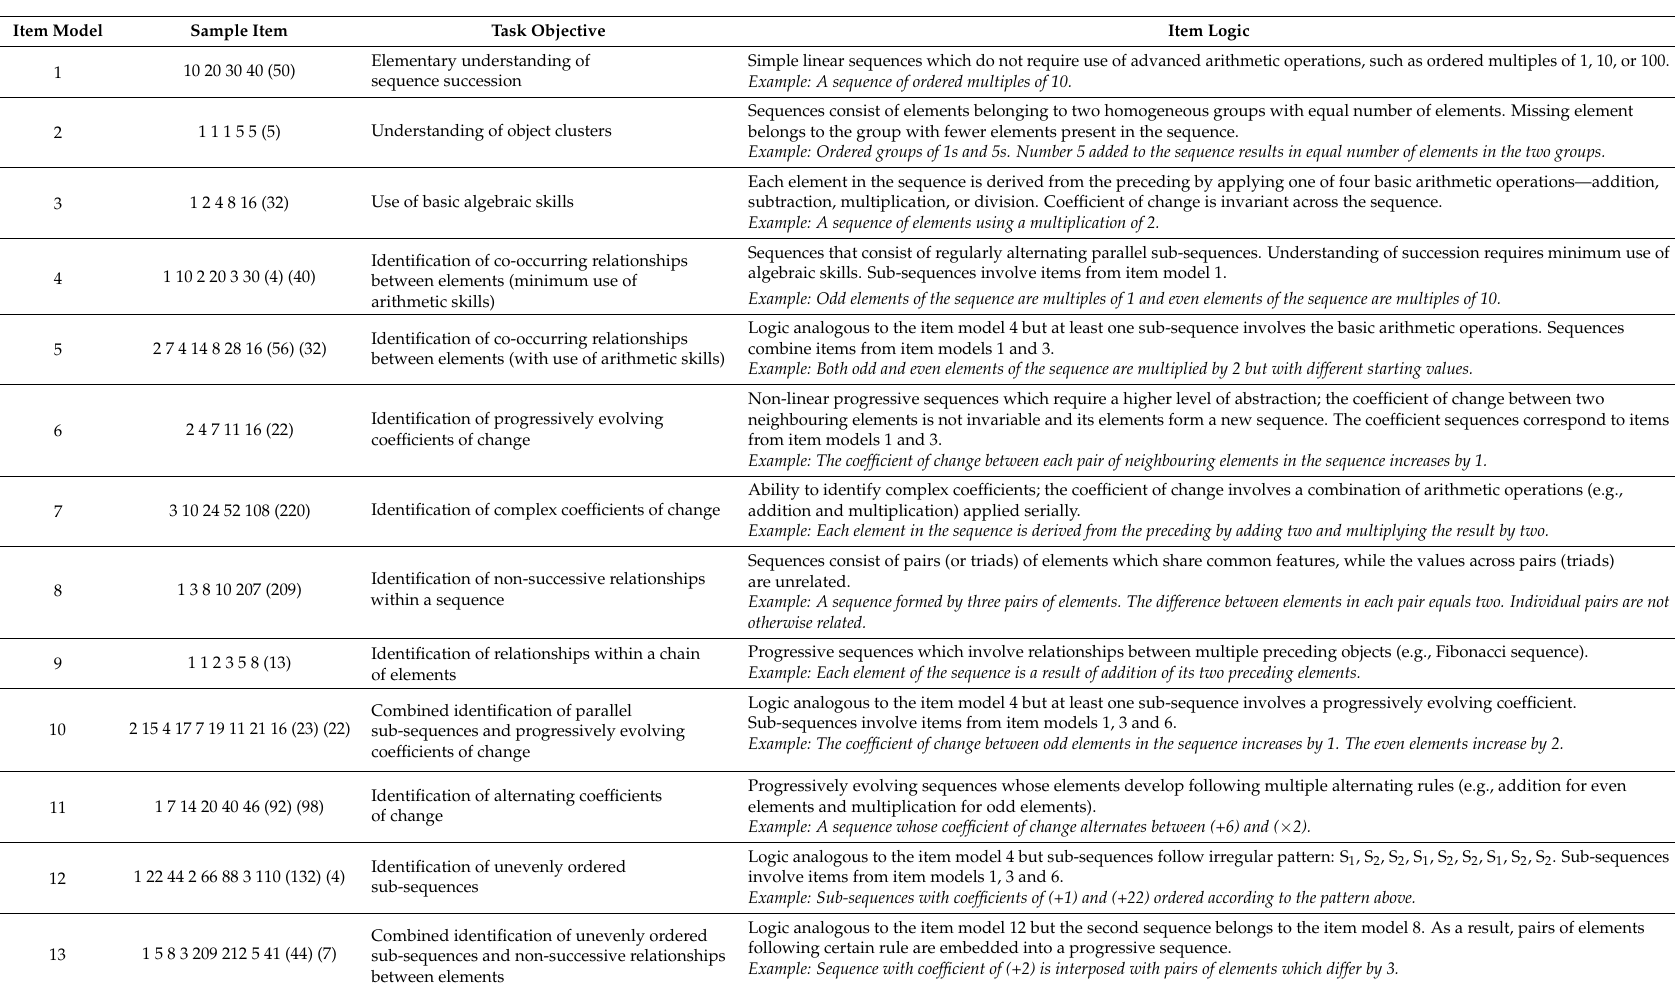
Table 2. Item model